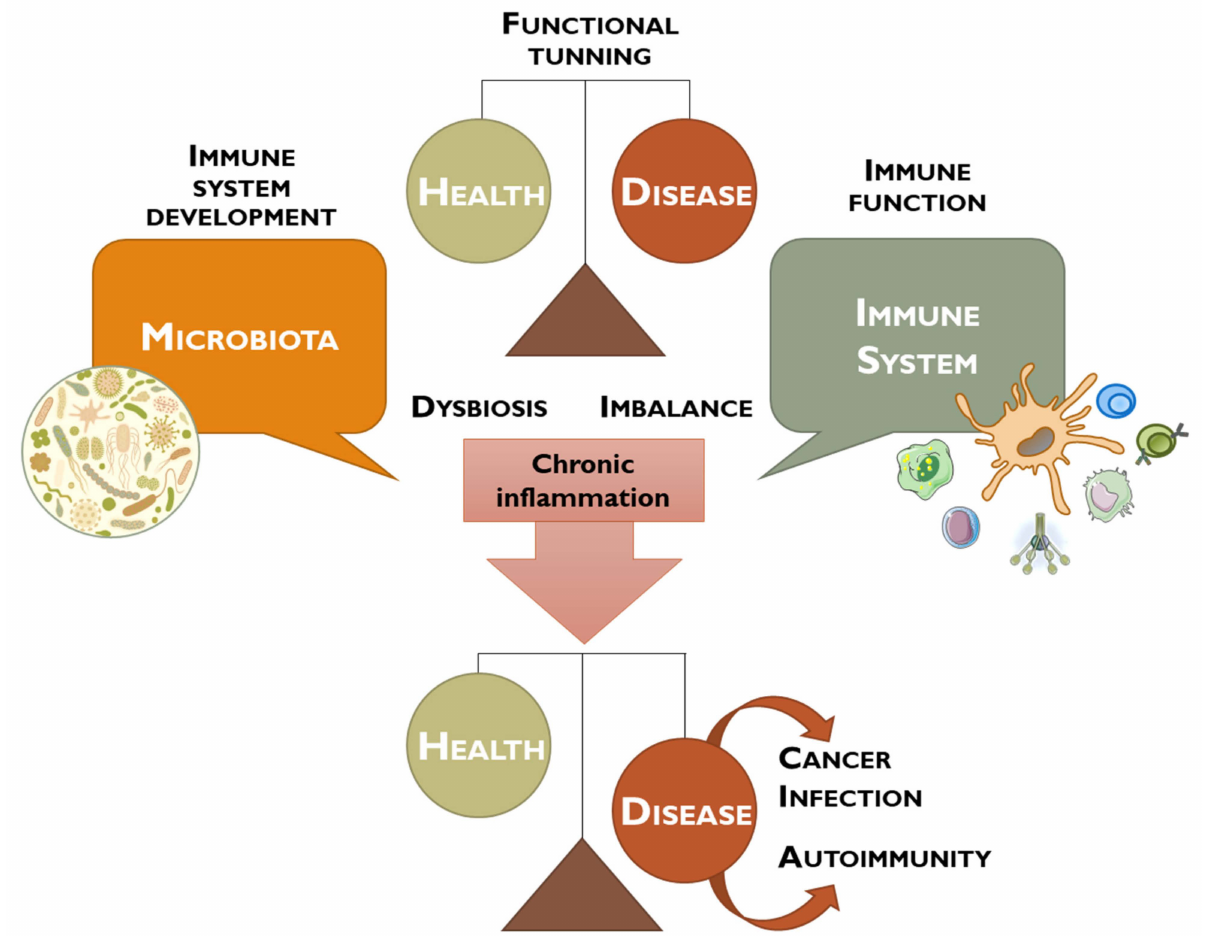
Figure 1. Schematic representation of the debate performed between microbiota and immune system to maintain the tight balance between health and disease. Dysbiosis contributes to an imbalance of the immune system, leading to chronic inflammation, and may promote the development of cancer, infection, or autoimmune